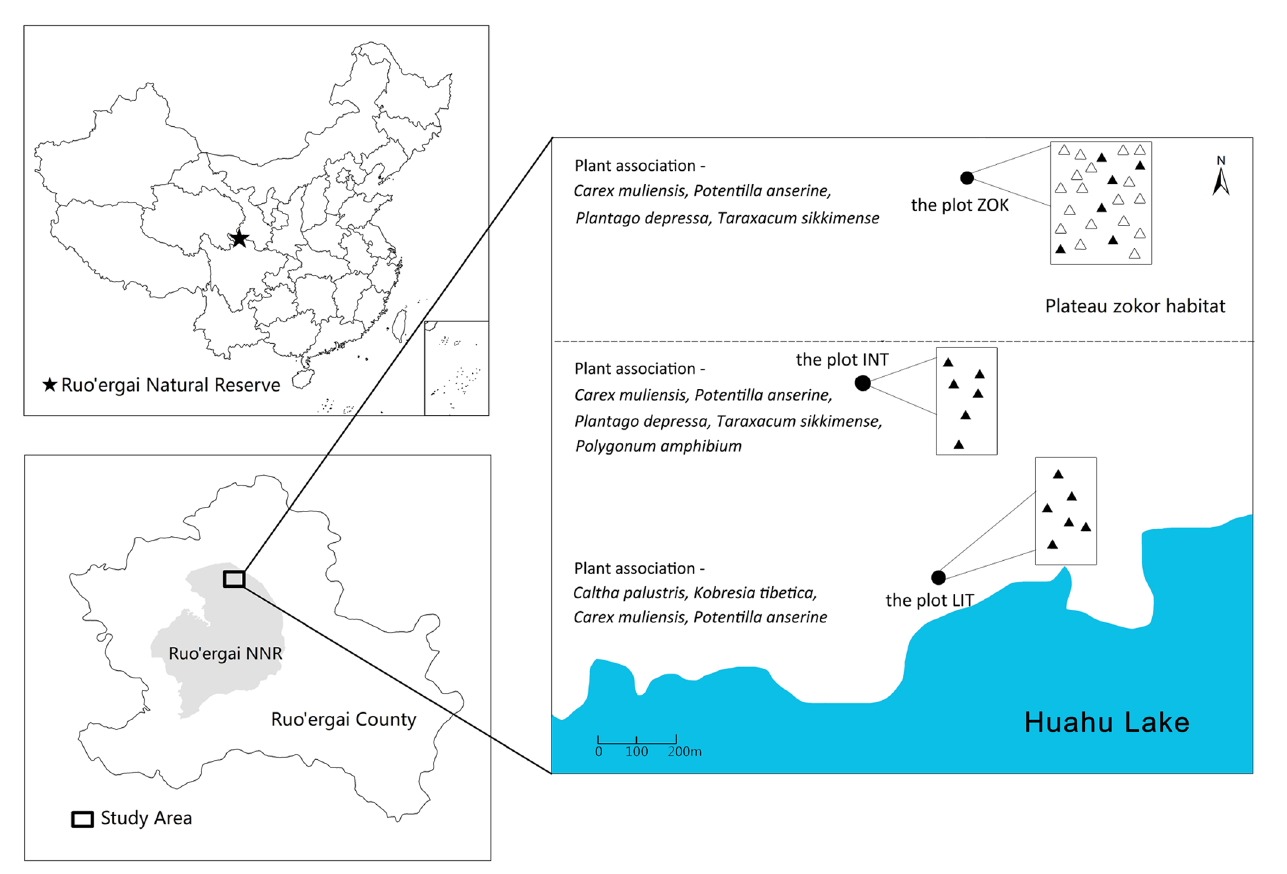
Fig. 1. Distribution of the study sites in the Zoige peatland. The three study plots (LIT, INT and ZOK) are shown by black dots. The distance from plot ZOK (33.929 ˚ N, 102.820 ˚ E; 3439m a.s.l.) to plot INT (33.923 ˚ N, 102.817 ˚ E; 3437m a.s.l.) is approximately 700 m, and the distance from plot INT to plot LIT (33.918 ˚ N, 102.818 ˚ E; 3435m a.s.l.) is approximately 600 m. Six permanent samples were taken each time, and are marked by solid triangle at each plot, and named as LIT, INTand CON, whereas for sample HUM, six samples were taken each time, and then, move to another location to take second, and third sets of samples, which are marked by open triangle at plot ZOK. The image at left bottom shows the border line of the Zoige County and the Zoige National Nature Reserve. The blue area in the right image represents Huahu Lake, whilst plateau zokor aggregates in the area above the dot line.